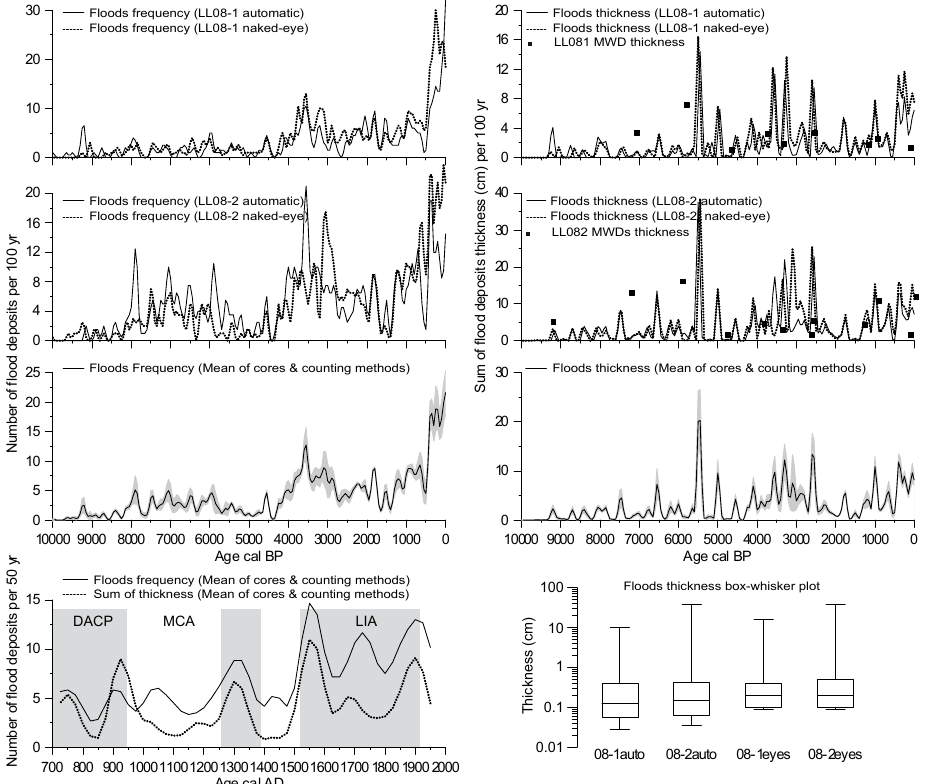
Fig. 5. Flood frequency and thickness sum per 100yr for both cores (LL08-1 and LL08-2) and from both naked-eye and automatic counting methods; thickness of mass-wasting deposits from both cores; average curves from the four inferred records and their descriptive statistics are presented in the bottom-left diagram and in Table 2, respectively. Main periods of flood frequency increase are underlined by gray bands. A magnified view of detailed flood frequency (events per 50yr) covering the last 1300yr is plotted at the bottom-left of the figure. Main climatic periods are indicated: Dark Ages Colp Period (DACP), Medieval Climate Anomaly (MCA), Little Ice Age